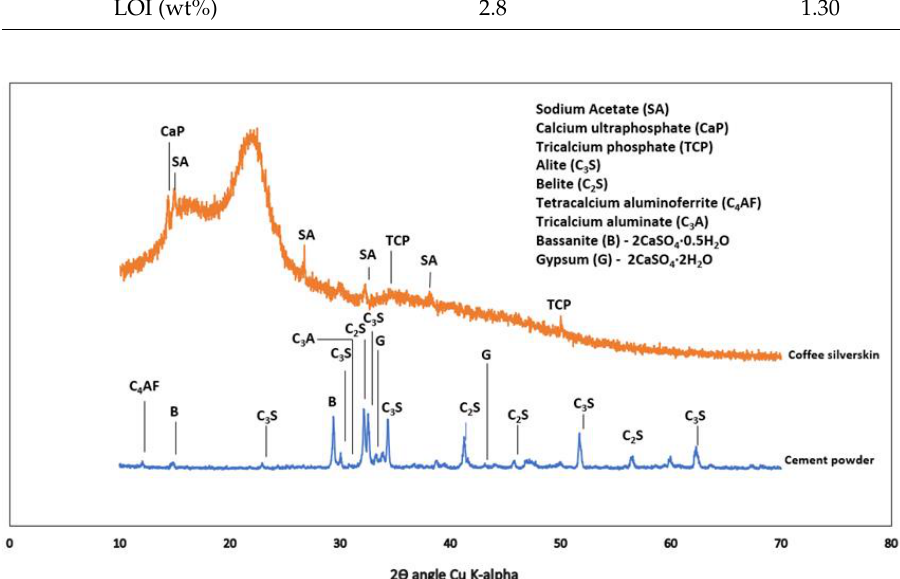
Figure 4. X-ray diffractogram of coffee silverskin and cement powder.